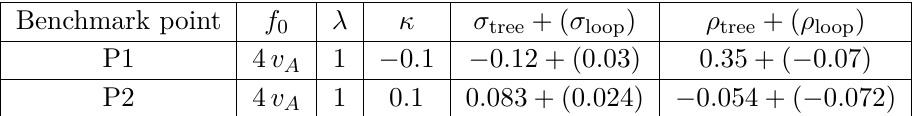
Table 1. Benchmark points in TH model with Z 2 symmetry broken only in the scalar potential. The loop corrections to the tree level σ and ρ values are given in